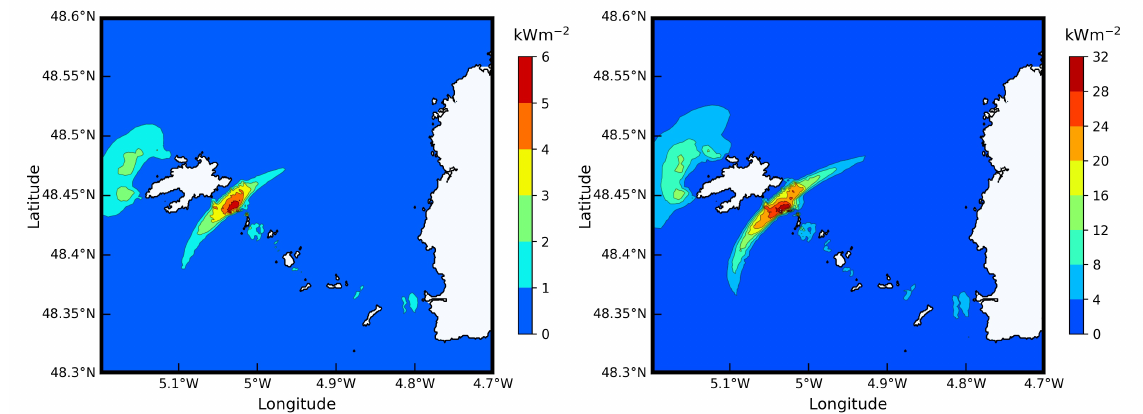
Figure 5. Cartography of ( left ) averaged and ( right ) maximum kinetic power density during a spring-neap tidal cycle (T = 14.765 days) resulting from M 2 , S 2 and M 4 harmonic components (adapted from